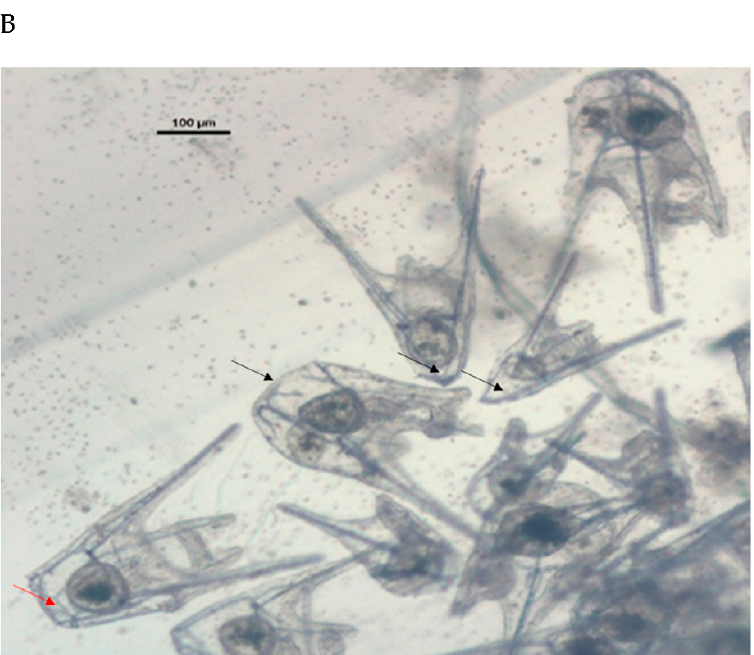
Figure 5. ( A ) Cryopreserved blastula embryos of S. granularis larval length after incubation in seawater after different incubation times (from 96 to 192 h at 18 °C) when using Paredes and Bellas’ 2014 cryopreservation protocol and 1.5 M of different CPAs. ( B ) Picture shows larvae obtained after 192 h of incubation of blastulas and cryopreserved with 1.5 M Gly. Red arrows show normal skeletogenesis, and black arrows point out frequent abnormalities.